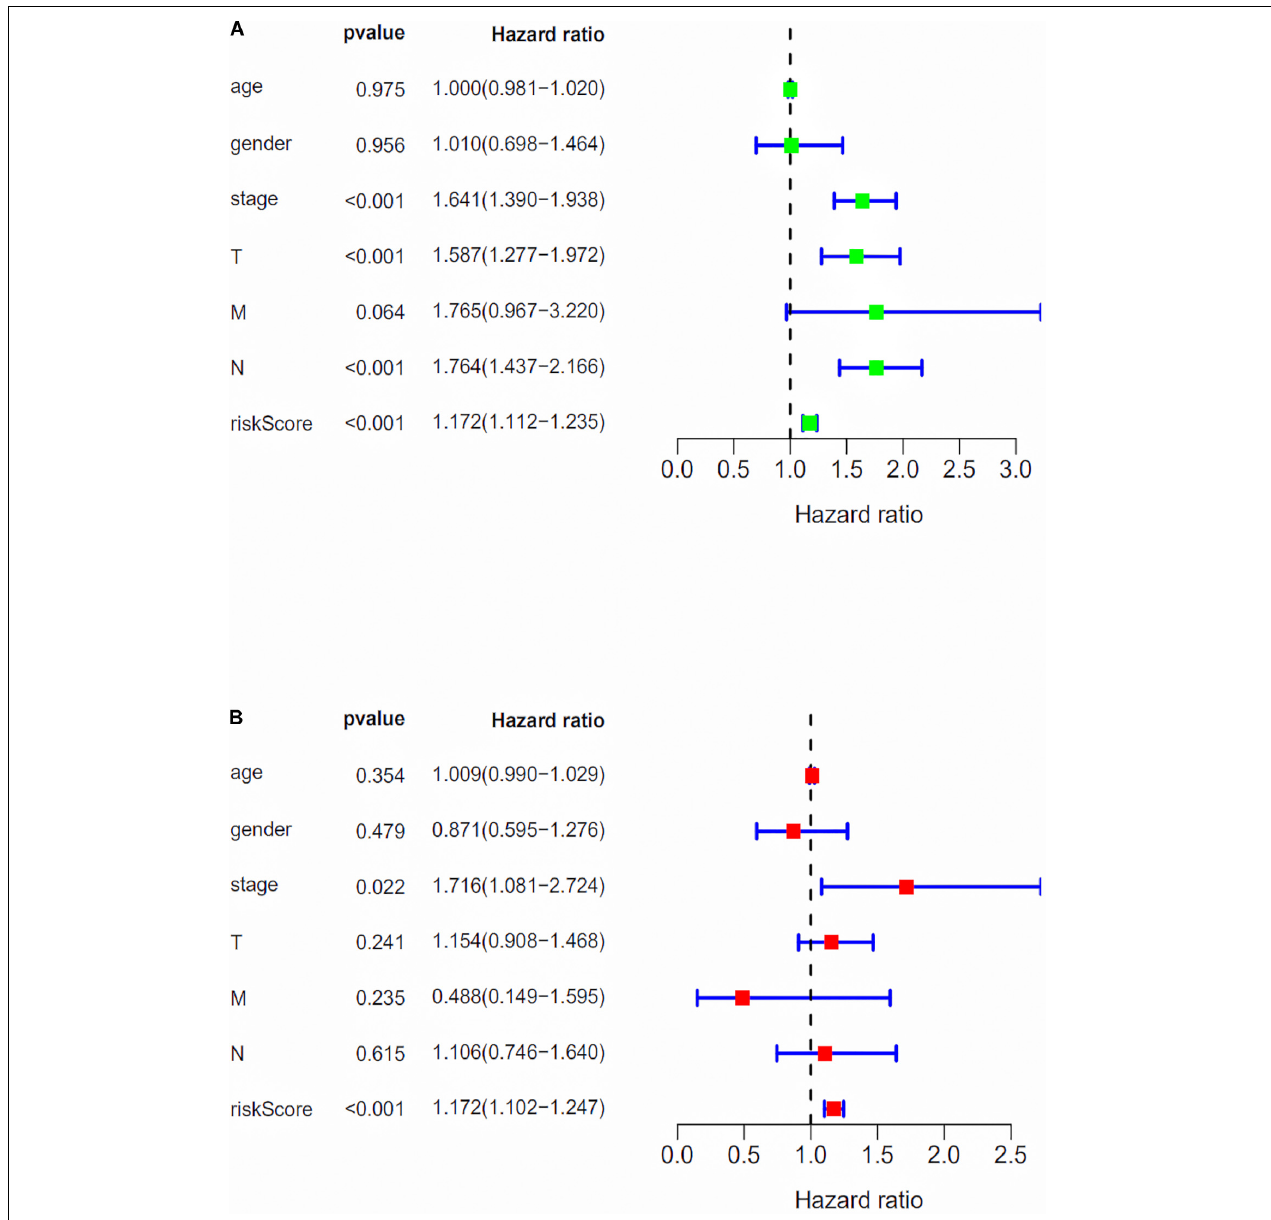
FIGURE 4 | Independent prognostic factor analysis of the risk score model with clinical risk factors. (A) Forest plot of univariate Cox regression analysis. (B) Forest plot of multivariate Cox regression analysis.